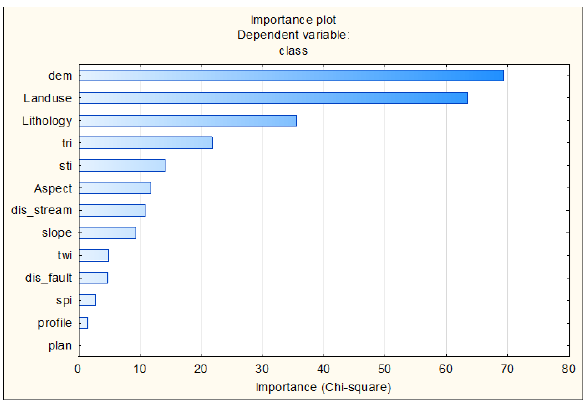
Figure 4. The important plot of conditioning factors using Chi-